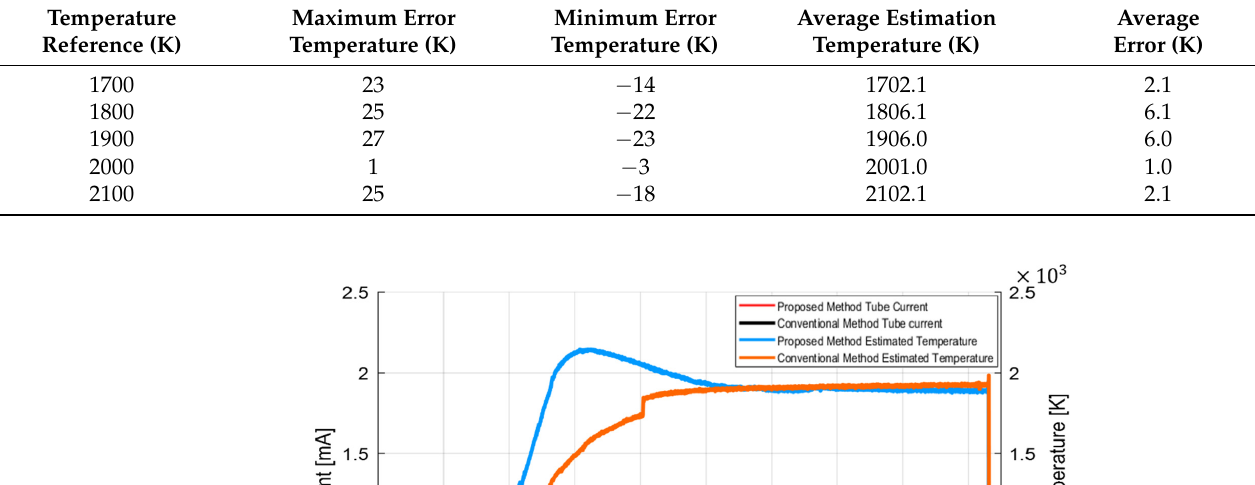
Table 2. Comparison of the temperature controller accuracy for different temperature references.